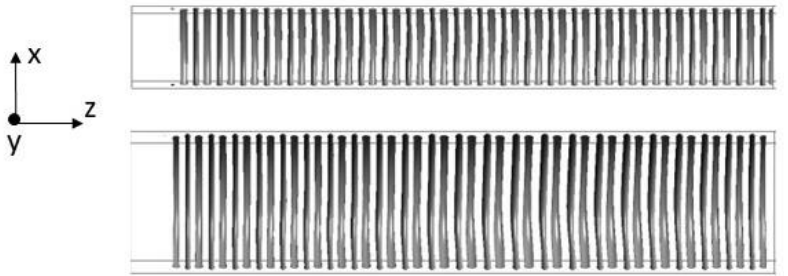
Figure 10. Iso-surfaces with a λ − 2 value of − 0.2 1/s 2 in simulations with the initial and doubled domain spans.